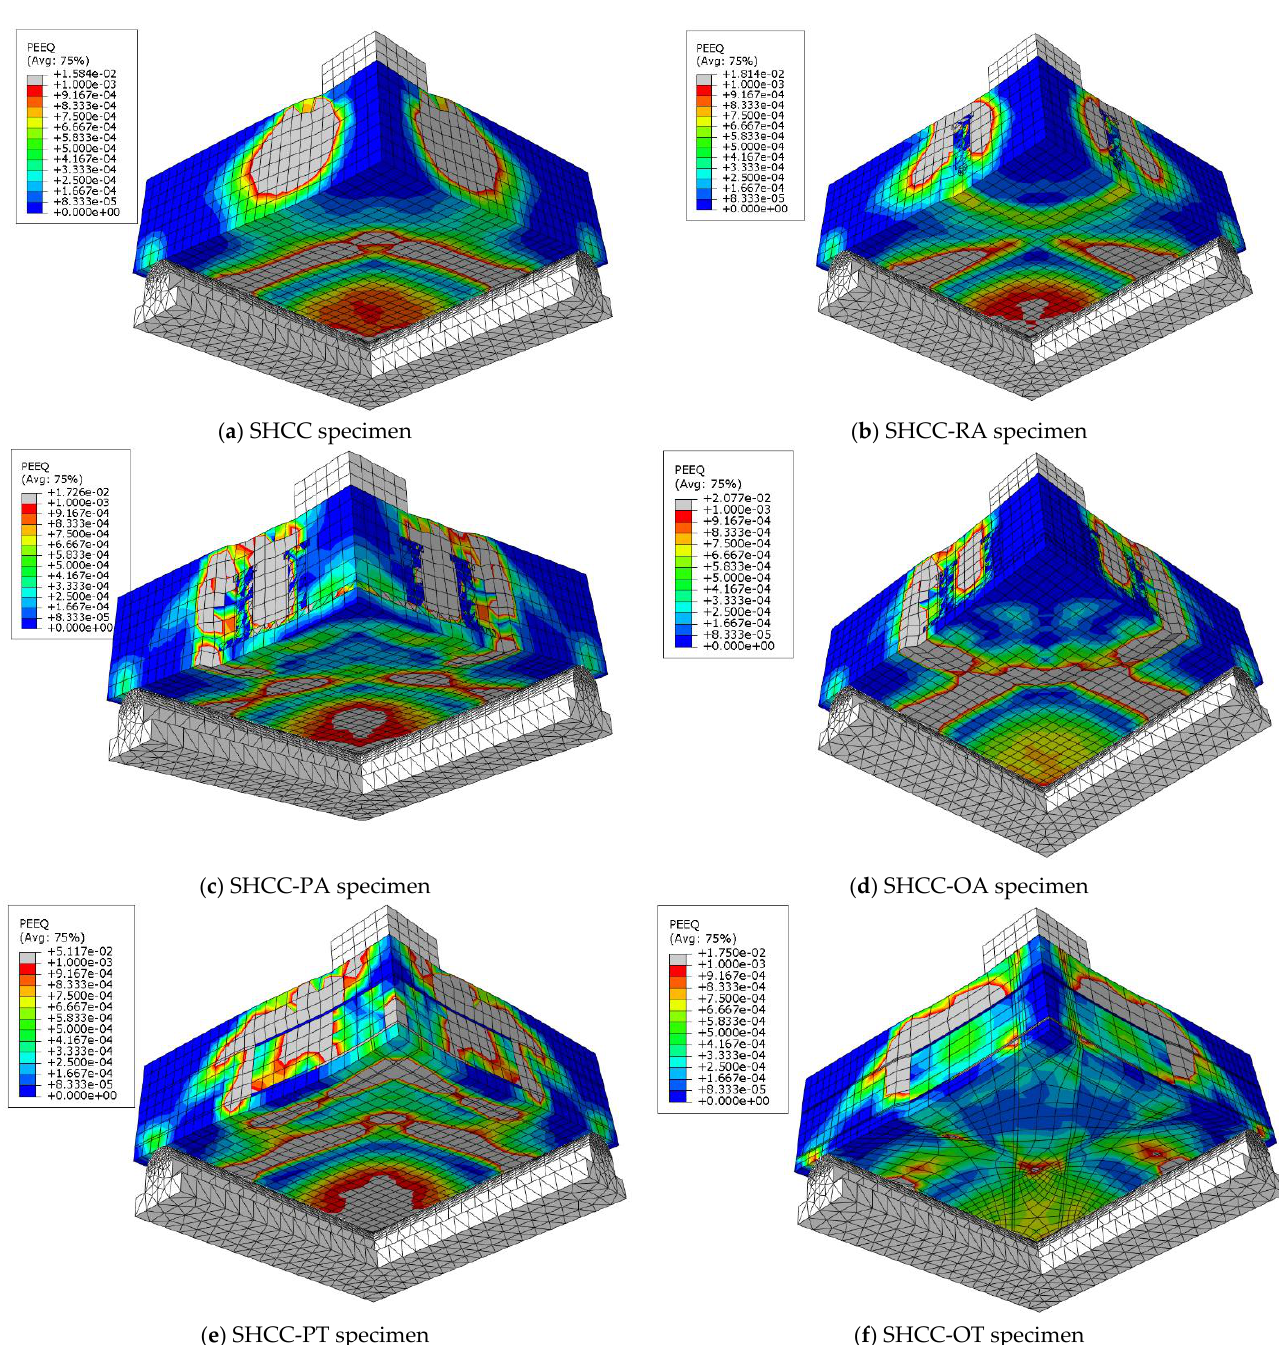
Figure 23. Analytical SHCC specimens cracks.